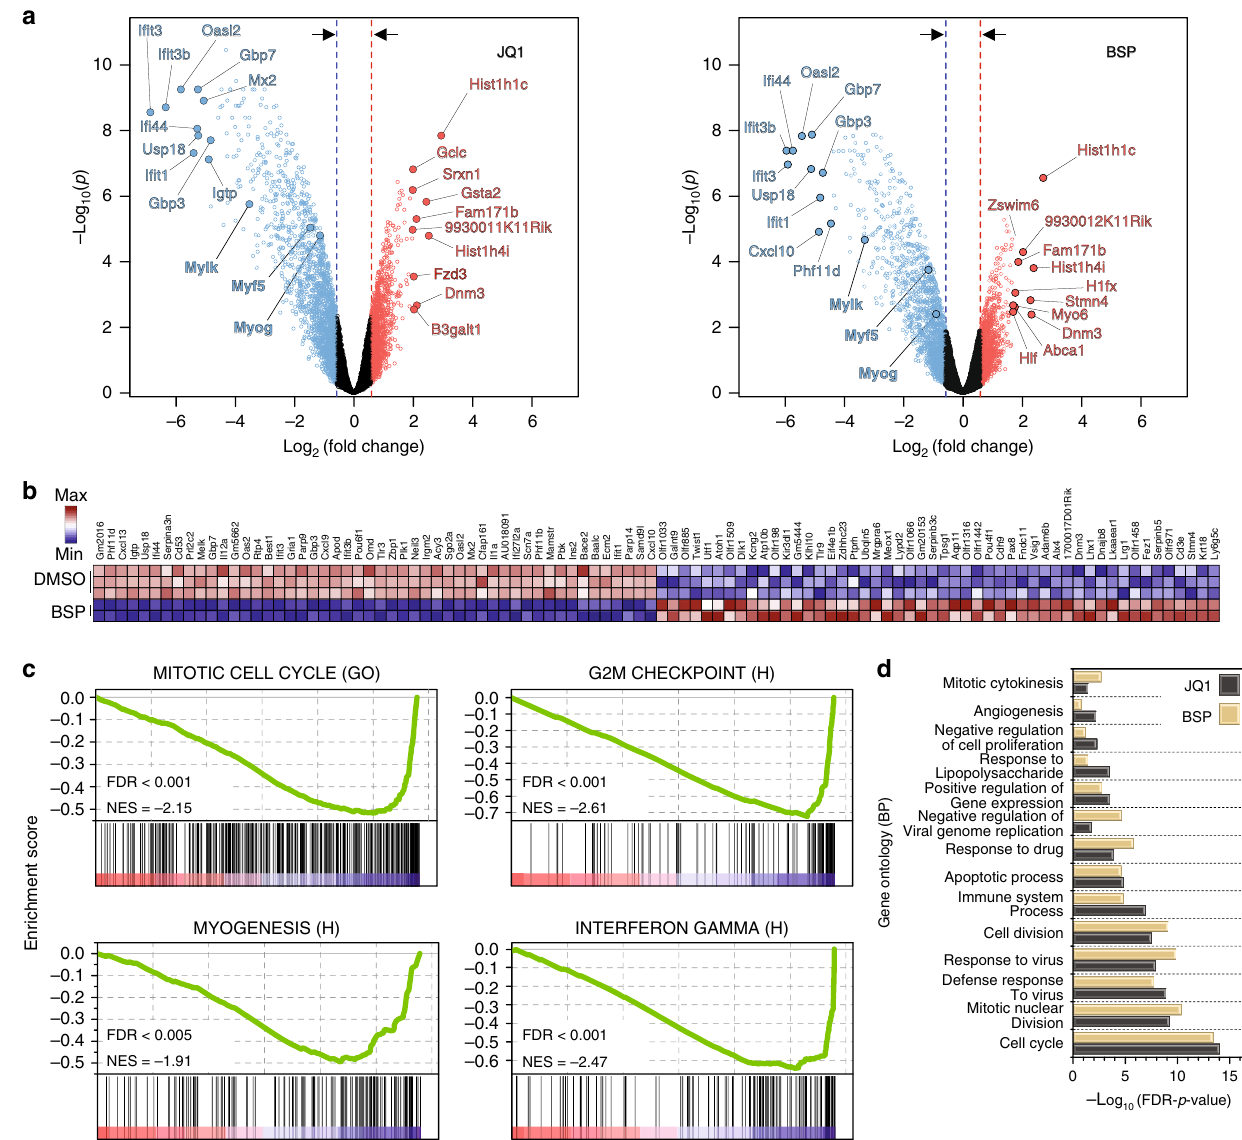
Fig. 5 Transcriptional response to BSP and JQ1 in C2C12 myoblasts. a Volcano plot of differentially expressed genes following 12 h treatment with BSP (left) or JQ1 (right) in C2C12 myoblasts. The top 10 genes are sorted by their fold change and are highlighted and colored in red (up-regulated) or blue (down- regulated). b Heatmap of the top 50 up/down-regulated genes in C2C12 myoblasts following 12 h BSP treatment based on two-sided signal-to-noise ratio (SNR) score and p < 0.05 calculated by the Benjamini-Hochberg t test. Dark blue indicates lowest expression; dark red indicates highest expression, with intermediate values represented by lighter shades, as indicated in the inset. Data are column normalized. c Gene set enrichment analysis (GSEA) demonstrating strong association with mitotic cell cycle (from the Gene Ontology (GO) MSigDB set, top left), G2M checkpoint (from hallmark MSigDB signatures, top-right), myogenesis (from hallmark MSigDB signatures, bottom-left), and interferon- γ (from hallmark MSigDB signatures, bottom-right) down-regulation signatures, following 12 h treatment of C2C12 cells with BSP. The plots show the running sum for the molecular signature database gene set within the C2C12/BSP data, including the maximum enrichment score and the leading edge subset of enriched genes. Normalized enrichment scores (NES) and false discovery rates (FDRs) are annotated in the insets. d GO enrichment (biological processes) for differentially expressed genes following 12 h treatment with JQ1 or BSP (calculated from differentially expressed genes with a Benjamini-Hochberg adjusted p -value < 0.001 and fold change